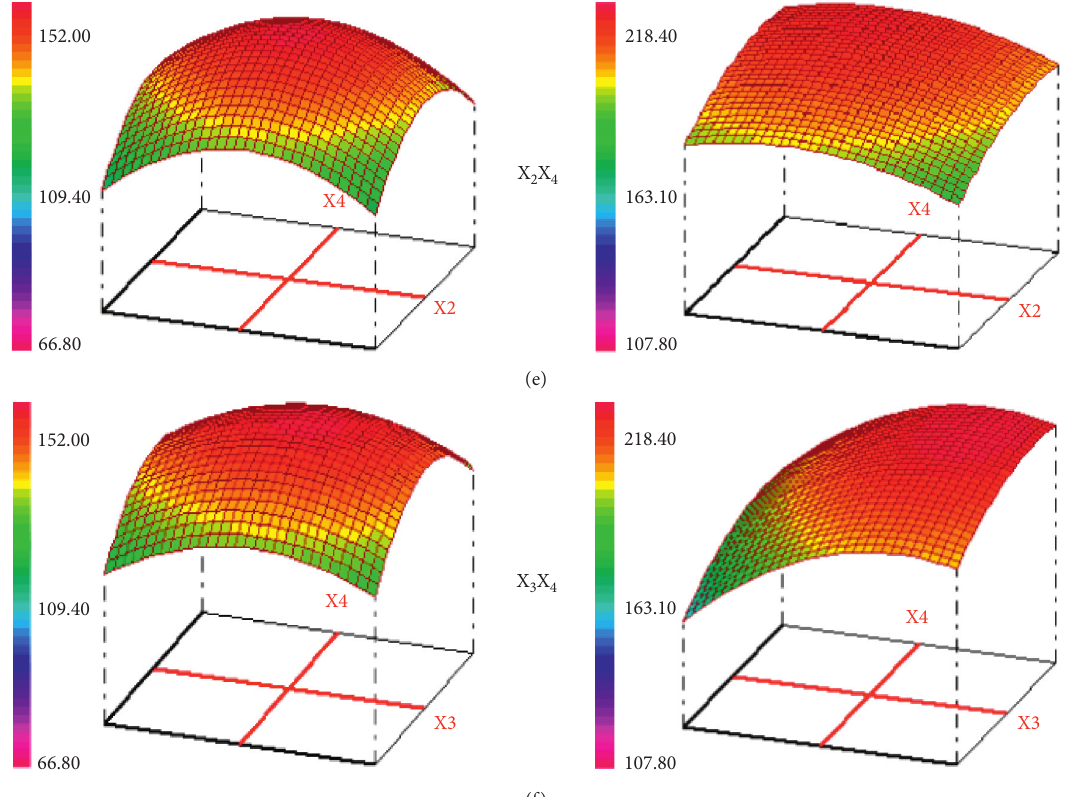
Figure 3: Response surface plot of TPC (mg GAE g-1 DW) of Eucalyptus marginata leaves extracts as a function of time, temperature, ratio s/m, and ethanol concentration obtained by maceration and ultrasound-assisted extraction methods. The extraction time (min, X 1 ), temperature ( ° C, X 2 ), liquid/solid ratio (ml/g, X 3 ), and ethanol concentration (%, X 4